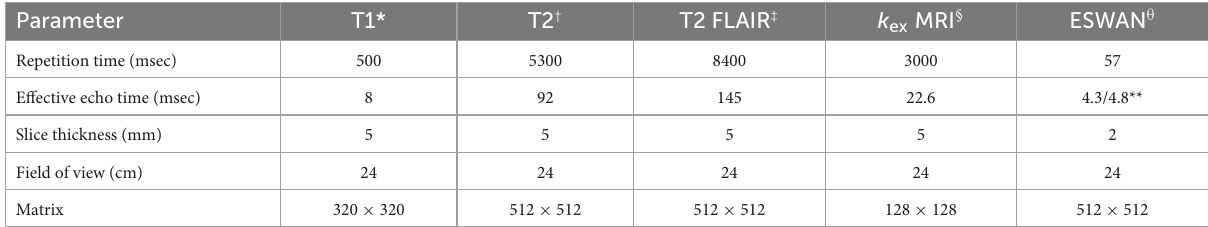
TABLE 1 Detailed parameters of each